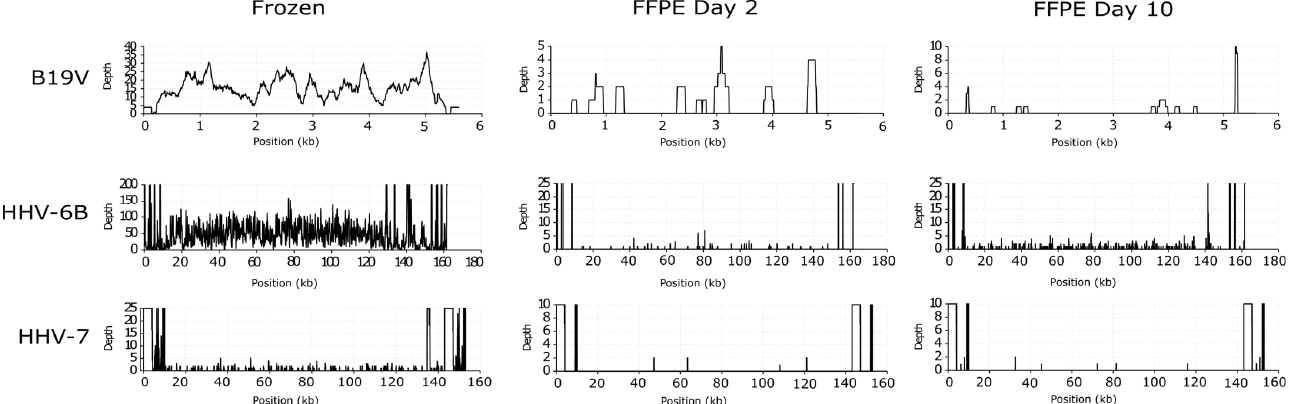
Figure 6. Coverage profiles of reconstructed viral DNA sequences in liver. From top to bottom, represented are the coverage profiles of parvovirus B19V (top), HHV-6B (middle), and HHV-7 (bottom) recovered from the frozen (left), and the respective FFPEs after 2 (middle) and 10 days of fixation (right). In the x-axis, genome position (kilobases, kb) illustrating the breadth coverage (= reads covering the noted viral reference) and in the y-axis, depth coverage (number of reads covering a specific nucleotide/area).